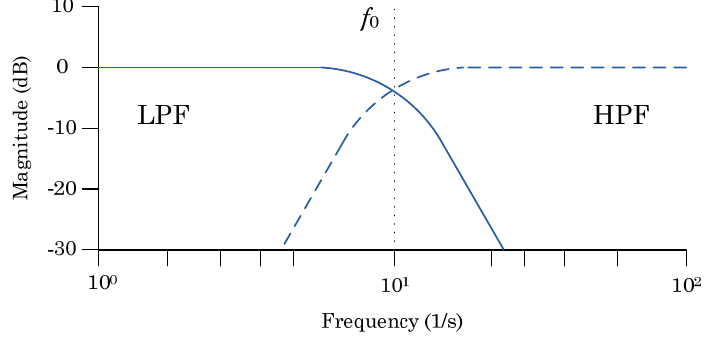
Figure 7. Cut-off frequency for complementary filter.